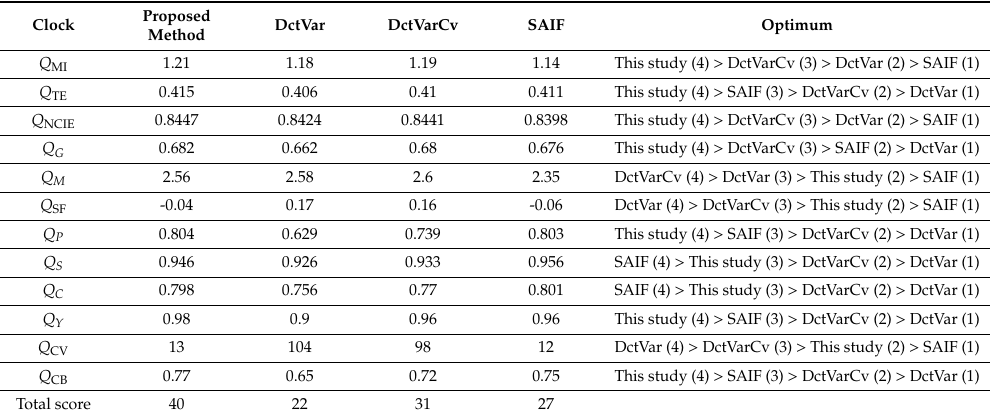
Table 2. List of clock fusion results and fusion quality